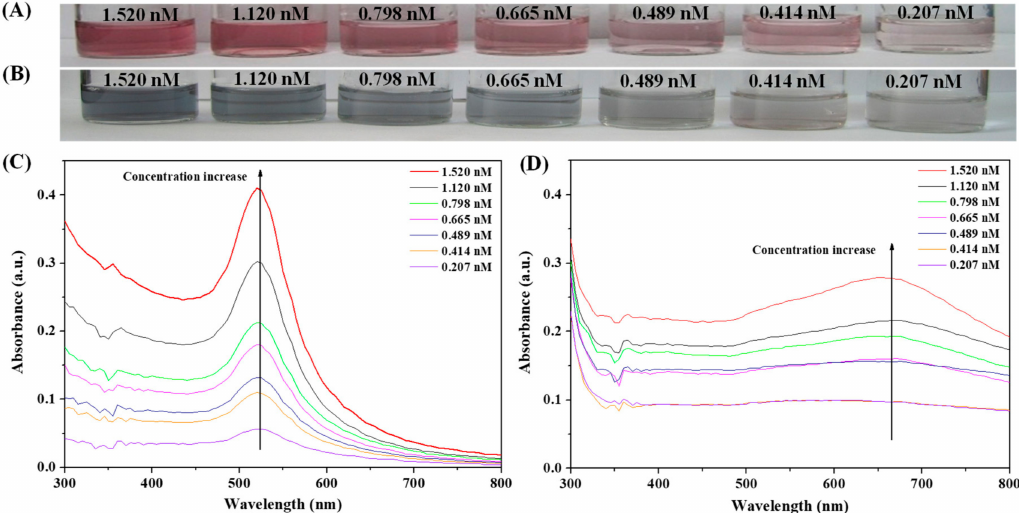
Figure 3. Photographs ( A , B ) and UV–Vis ( C , D ) absorption spectra of solution having di ff erent concentration of AuNPs (from 0.207 to 1.52 nM) in the absence ( A , C ) and presence ( B , D ) of creatinine (50 µ